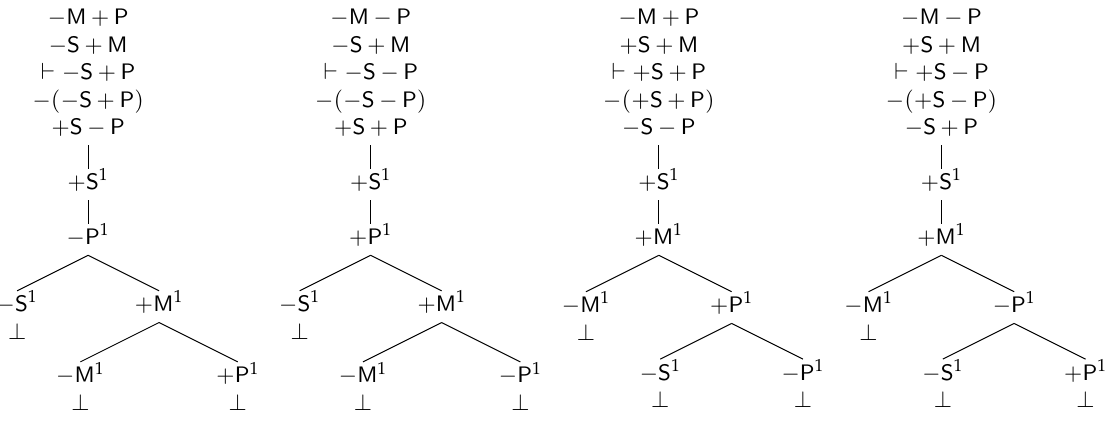
Scheme 1. Term Functor Logic (TFL) tableaux